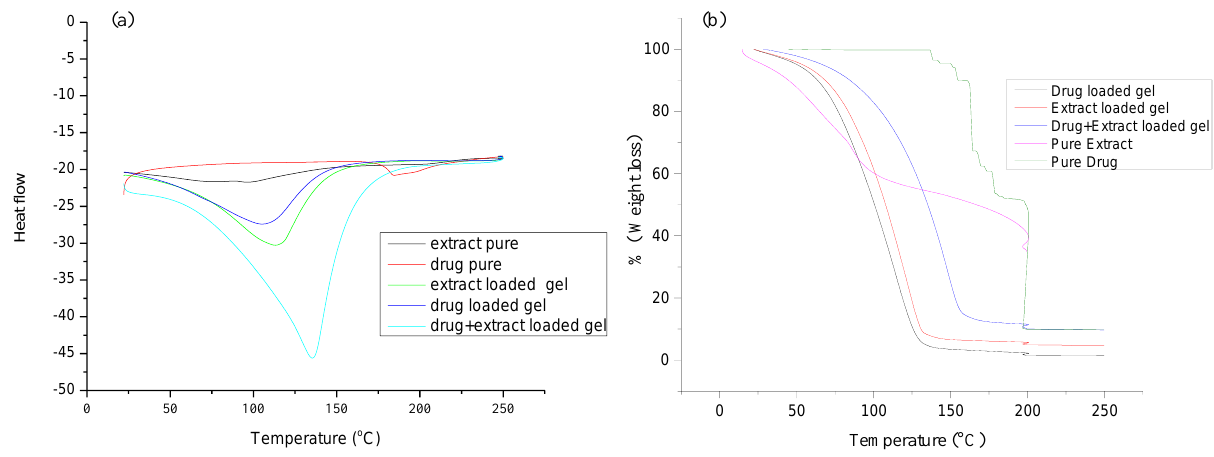
Figure 3. DSC ( a ) and TGA ( b ) curves of the active ingredients and prepared formulations.